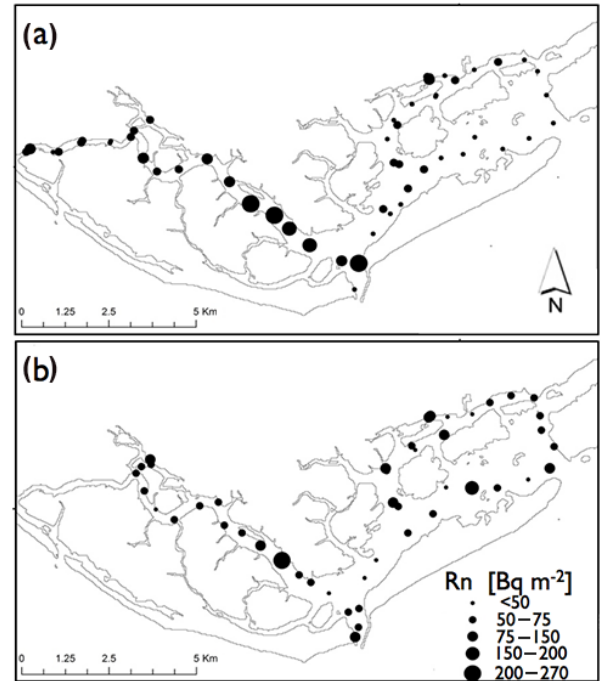
Figure 2. Map showing the distribution of radon inventories (Bqm − 2 ) within the main channels, during ebb (a) and flood (b) , for the radon survey conducted in 2010. For more details regard- ing the radon budget in both December 2009 and June 2010, see Table